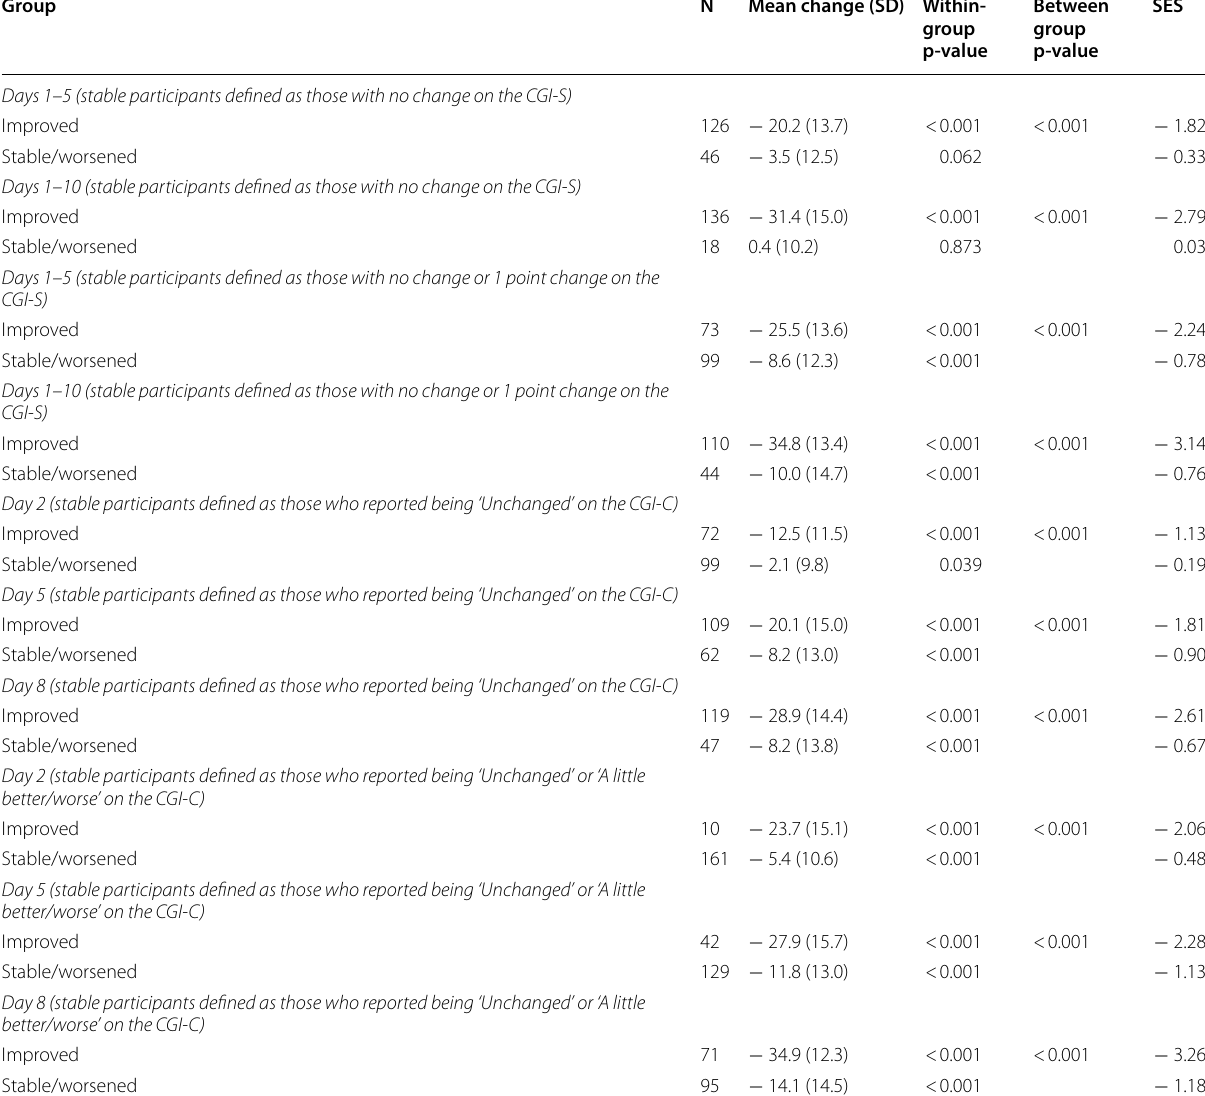
Table 7 Ability to detect change: mean change scores and Standardized Effect Sizes (SES) on the chest-related ePRO summary score with change groups based on change in the CGI-S between Visit 1 (baseline) to Day 5 (n 2 (n 191), Day 5 (n 187) and Day 8 (n = = =